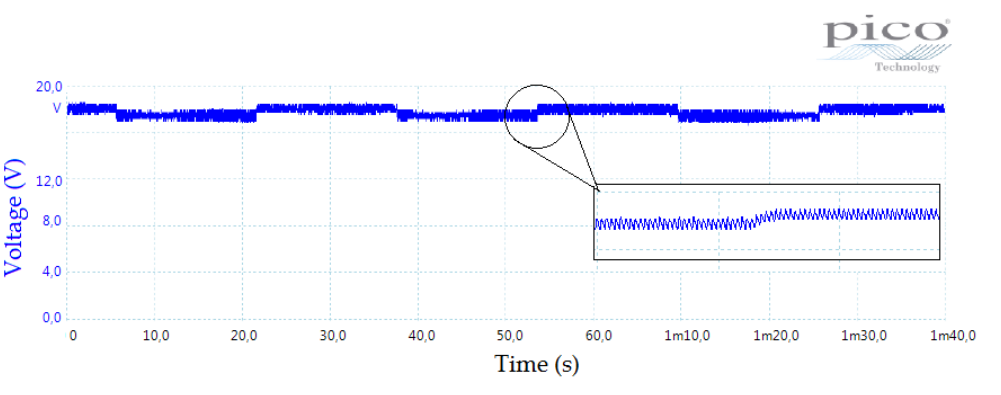
Figure 8. Automatic change in light intensity corrupted by the blinking